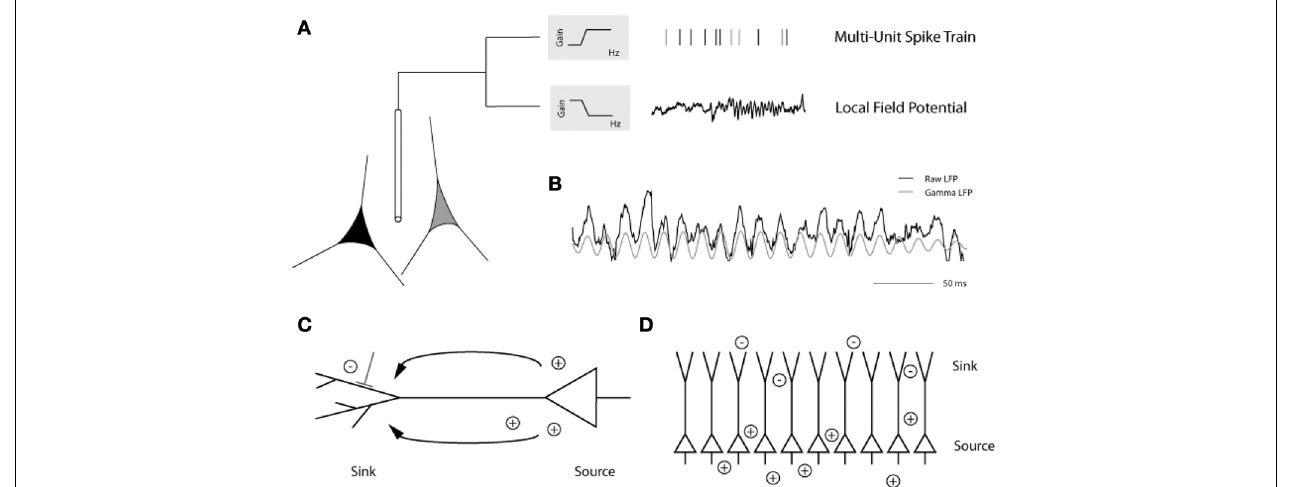
FIGURE 3 | (A) Placing an extracellular electrode in the brain measures the mean extracellular field potential originating from the activity of a population of neurons surrounding the electrode tip. The signal is high-pass filtered and the resulting multiunit action potentials are detected. The local field potential (LFP) is the low frequency component (up to 200Hz) of the signal with a frequency composition that varies over time. Here, prominent gamma band oscillations (between 30 and 90Hz) are visible in the later part of the LFP trace. (B) In this example